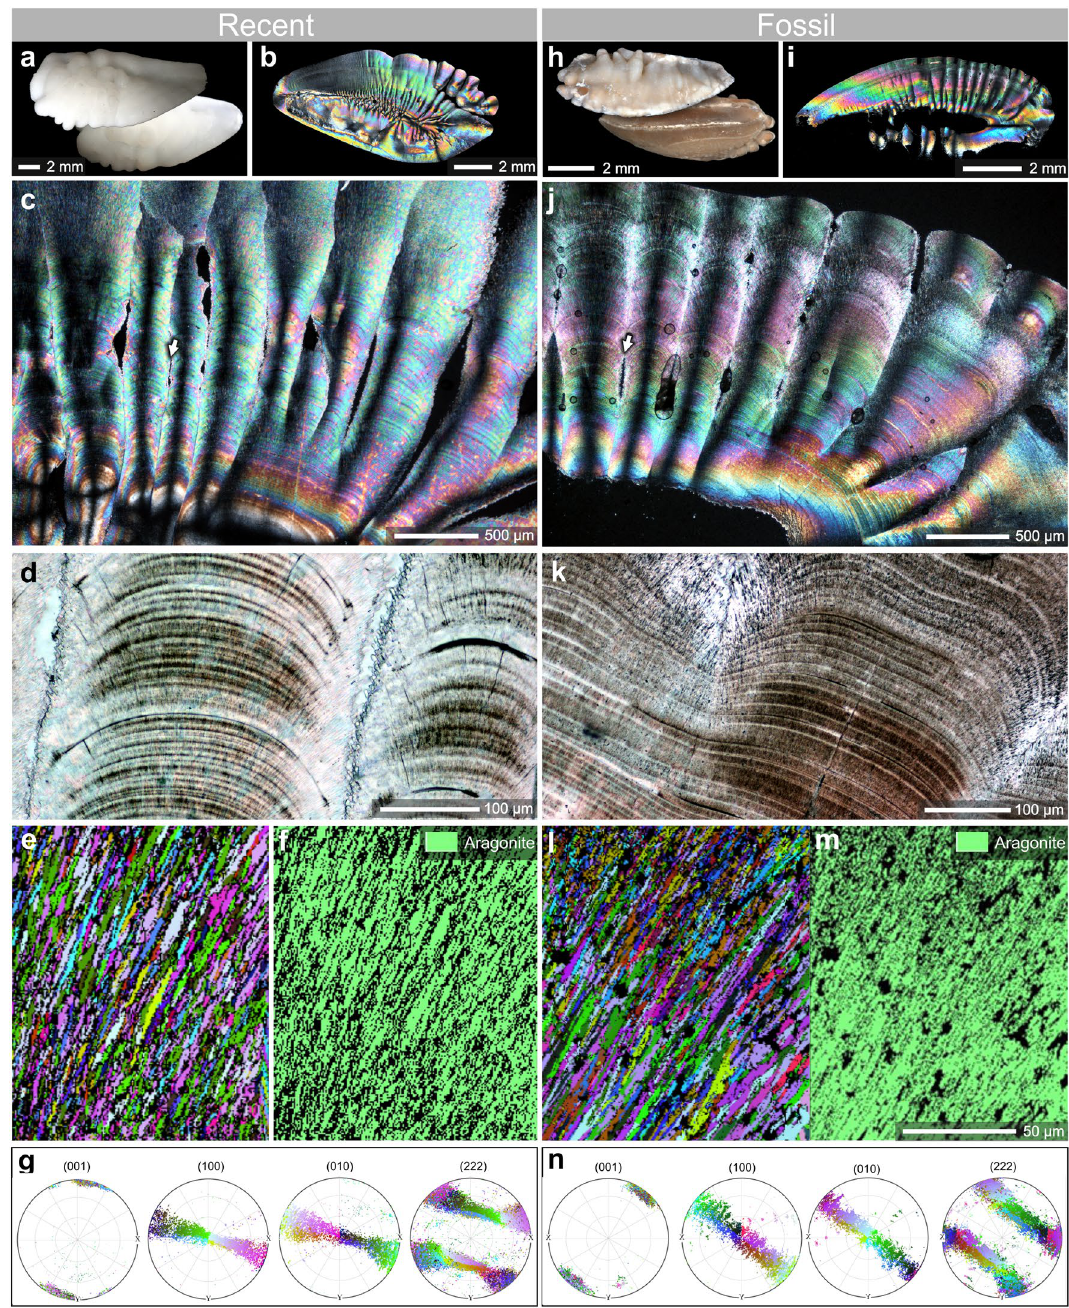
Figure 1. Morphological, microstructural and crystallographic similarity of modern Phycis phycis ( a–g ) and fossil Phycis tenuis ( h–n ) saggital otoliths. Modern ( a ) and fossil ( h ) sagittas are slim and elongated; the outer face (distal surface) most commonly is composed of irregular thickenings/protuberances and grooves. Thin-sections in polarized ( b,c,i,j ) and normal transmitted light ( d,k ) show numerous growth rings and point to ontogenetic continuity of protuberances (columns in longitudinal cut; occasionally separated by spindle- shaped voids, white arrows). Crystallographic orientation images (EBSD) show aragonite crystals of similar size in modern ( e ) and fossil ( l ) samples (phase maps ( f,m ) confirm aragonite mineralogy of both samples); pole figures are fully comparable between modern ( g ) and fossil samples ( n ): same crystal size, distribution, inclination, azimuthal dispersion and turbostratic distribution in the plane (222). ZPAL P.21/R-OTH-242/001 ( a–g ); ZPAL P.21/ C-OTH-07/006 ( h–n ). The BungeColorKey palette (more accessible for color-blind users) from MTEX was used to create orientation images and the pole